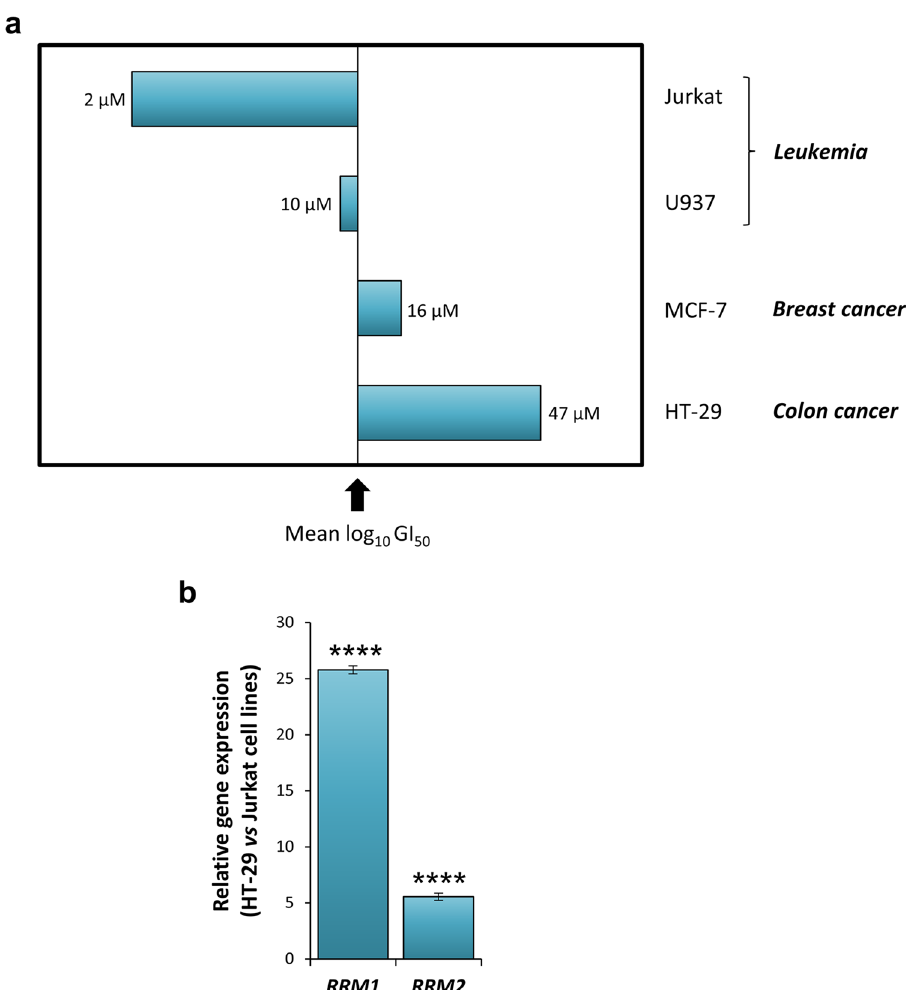
Figure 5. Ni(S-tcitr) 2 sensitivity of human cancer cell lines correlates with the transcriptional levels of RNR subunits. ( a ) Antiproliferative activity of Ni(S-tcitr) 2 on the indicated human cancer cell lines. GI 50 values, determined after a 24 h treatment, are indicated. The midline in the graph represents the mean of the log 10 GI 50 values measured across the whole set of the human cancer cell lines comprised within the ‘US National Cancer Institute 60 human tumor cell line anticancer drug screen’ 52 ; this mean GI 50 value was subtracted from those determined for each individual cell line. Hypersensitive and hyposensitive cell lines (compared to the mean sensitivity of the whole set of analyzed cell lines) are shown as left-deflecting and right-deflecting bars, respectively. ( b ) Relative abundance of the mRNAs coding for the RRM1 and RRM2 subunits of human RNR in the least Ni(S-tcitr) 2 sensitive (HT-29) and the most sensitive (Jurkat) cancer cell line. Transcript levels were determined by Real-Time RT-PCR after 24 h growth under standard conditions; data, which represent the average ± SD of three biological replicates, were normalized using GAPDH as a housekeeping reference gene. Data were analyzed by one-way ANOVA followed by Dunnett comparison post-hoc test (**** P -value <